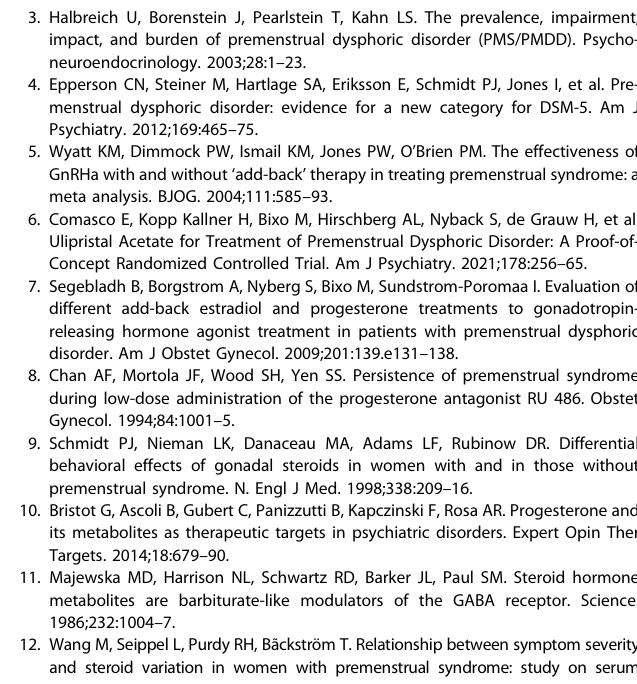
Fig. 4 Associations between emotion-induced brain activity and anxiety scores in subjects with PMDD ( N = 29) during the late-luteal phase of the menstrual cycle ( p FWE < 0.05, TFCE). Upper: Brain slice depicting clusters in which there was a signi fi cant linear relationship between brain activity during task [Faces>Shapes contrast] and anxiety scores ( p FWE < 0.05, TFCE). The analysis was conducted voxel-wise within a mask combining brain regions showing increased task-related activation in subjects with PMDD during the late-luteal phase. Lower: Corresponding scatter plots illustrating relationships between mean parameter estimates extracted from signi fi cant clusters and anxiety scores. Simple regression lines were added for visualization. DRSP Daily Record of Severity of Problems, FWE Family Wise Error correction, PMDD Premenstrual Dysphoric Disorder, TFCE Threshold-Free Cluster